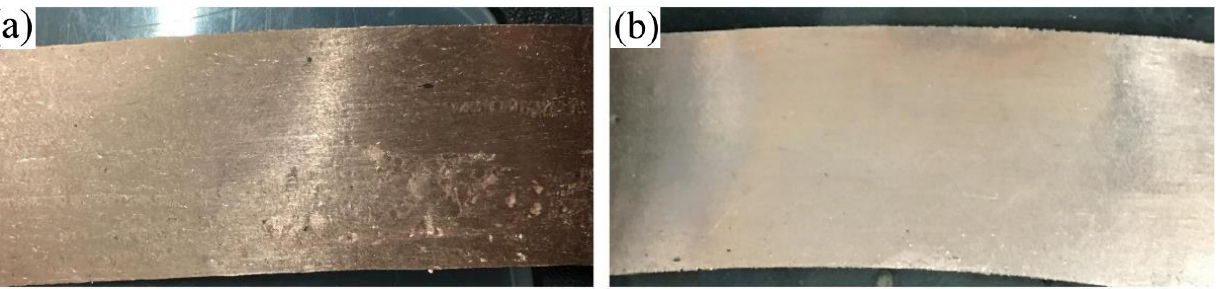
Figure 3. Surface morphology of C70250 copper alloy strip with different microstructure under 98% cold rolling deformation. ( a ) EG strip and ( b ) CG strip. 98% cold rolling deformation. ( a ) EG strip and ( b ) CG